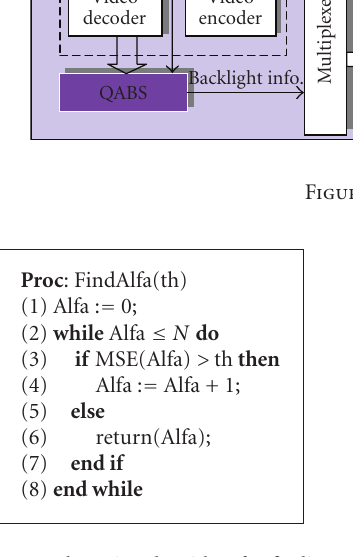
Figure 9: Setup for our